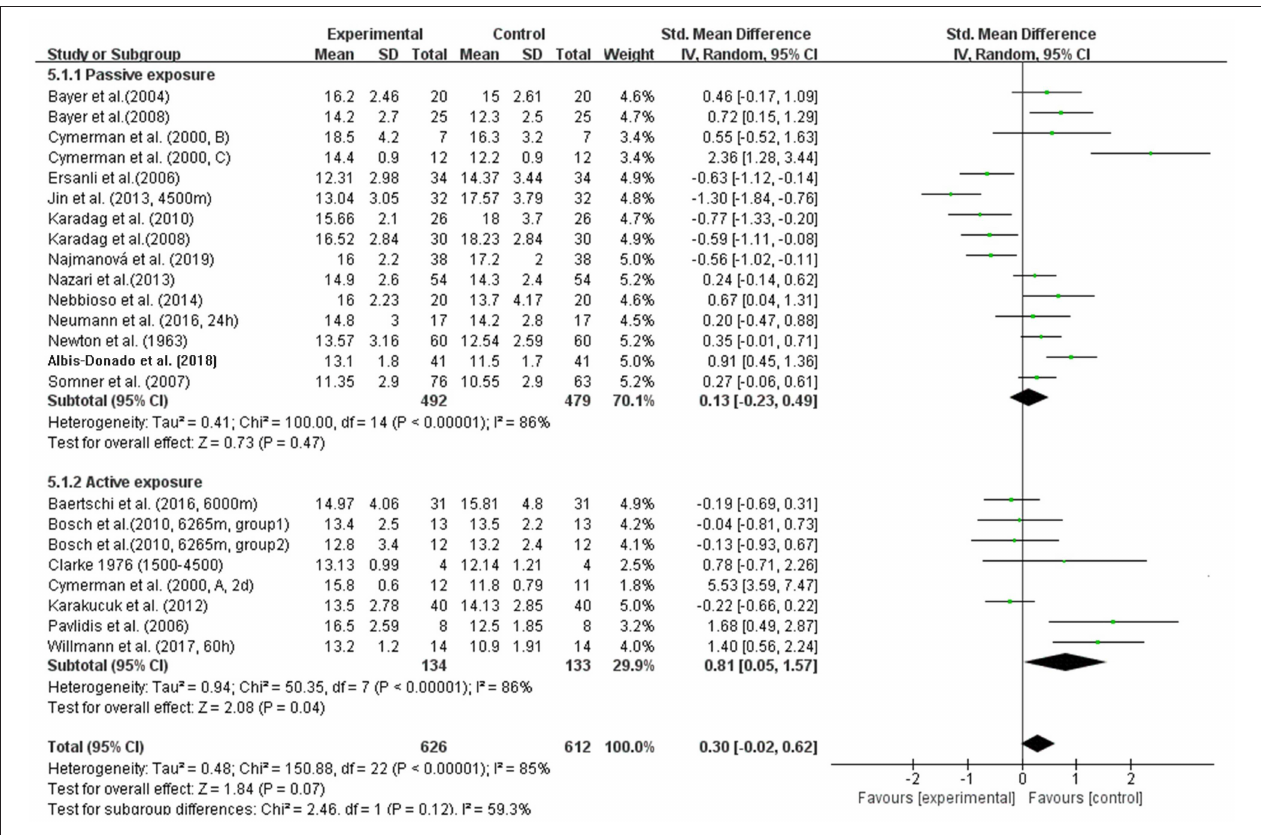
FIGURE 6 | Forest plot of subgroup analysis for passive and active exposure to high